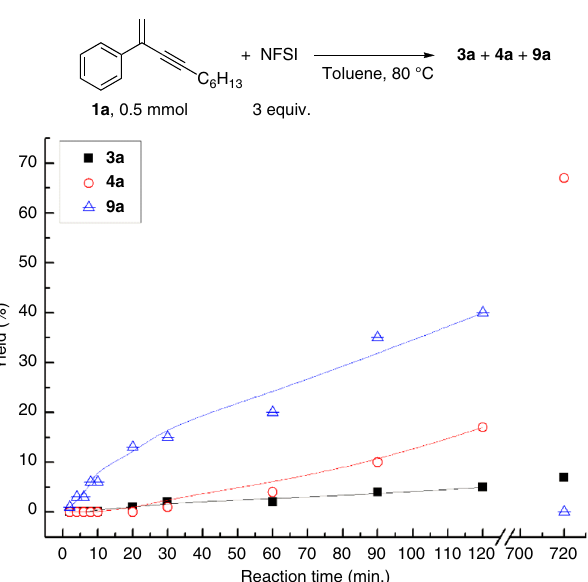
Fig. 6 Kinetic studies. Kinetic pro fi les for the formation of 3a , 4a and active intermediate 9a